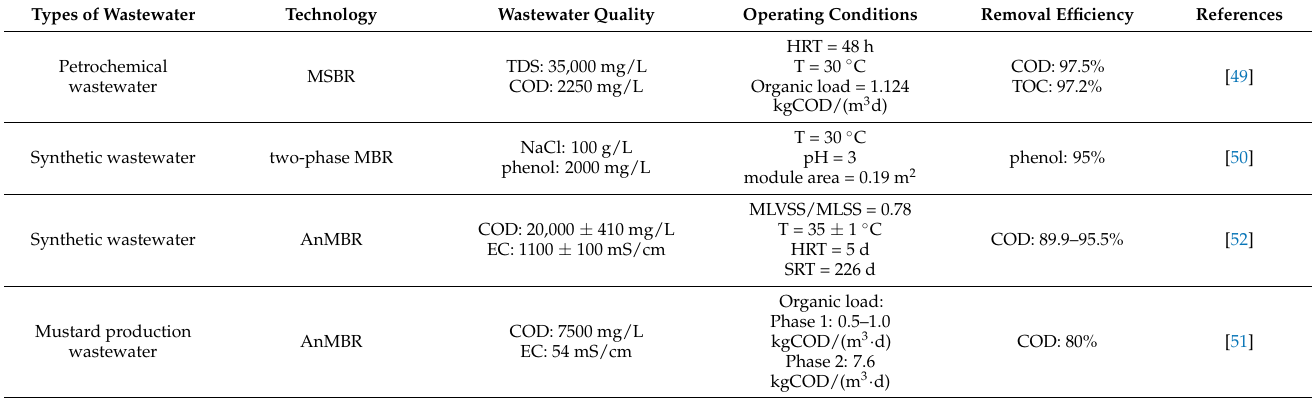
Table 4. Performance and experimental conditions of MBR for the treatment of saline